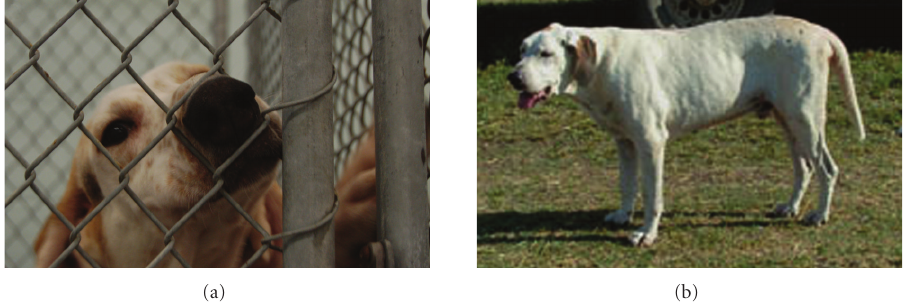
Figure 1: Both humans and dogs have a wide clinical presentation with Le. infantum . These presentations vary from (a) no clinical signs and robust healthy behavior in a young healthy Foxhound to (b) multiple clinical signs (polysymptomatic) including poor hair coat, enlarged liver and spleen, and crusty cutaneous lesions seen on the rump in an older